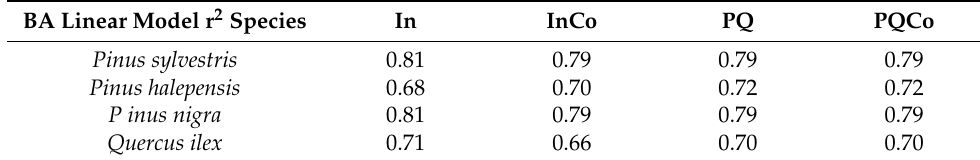
Table A5. Determination coefficient r 2 calculated over expected BA vs. observed BA by species, aggregation level (individual (In) and plot-quantile classes (PQ)), and Equations (1) and (2) (Co for competition); calculations done at individual level with untracked individuals.